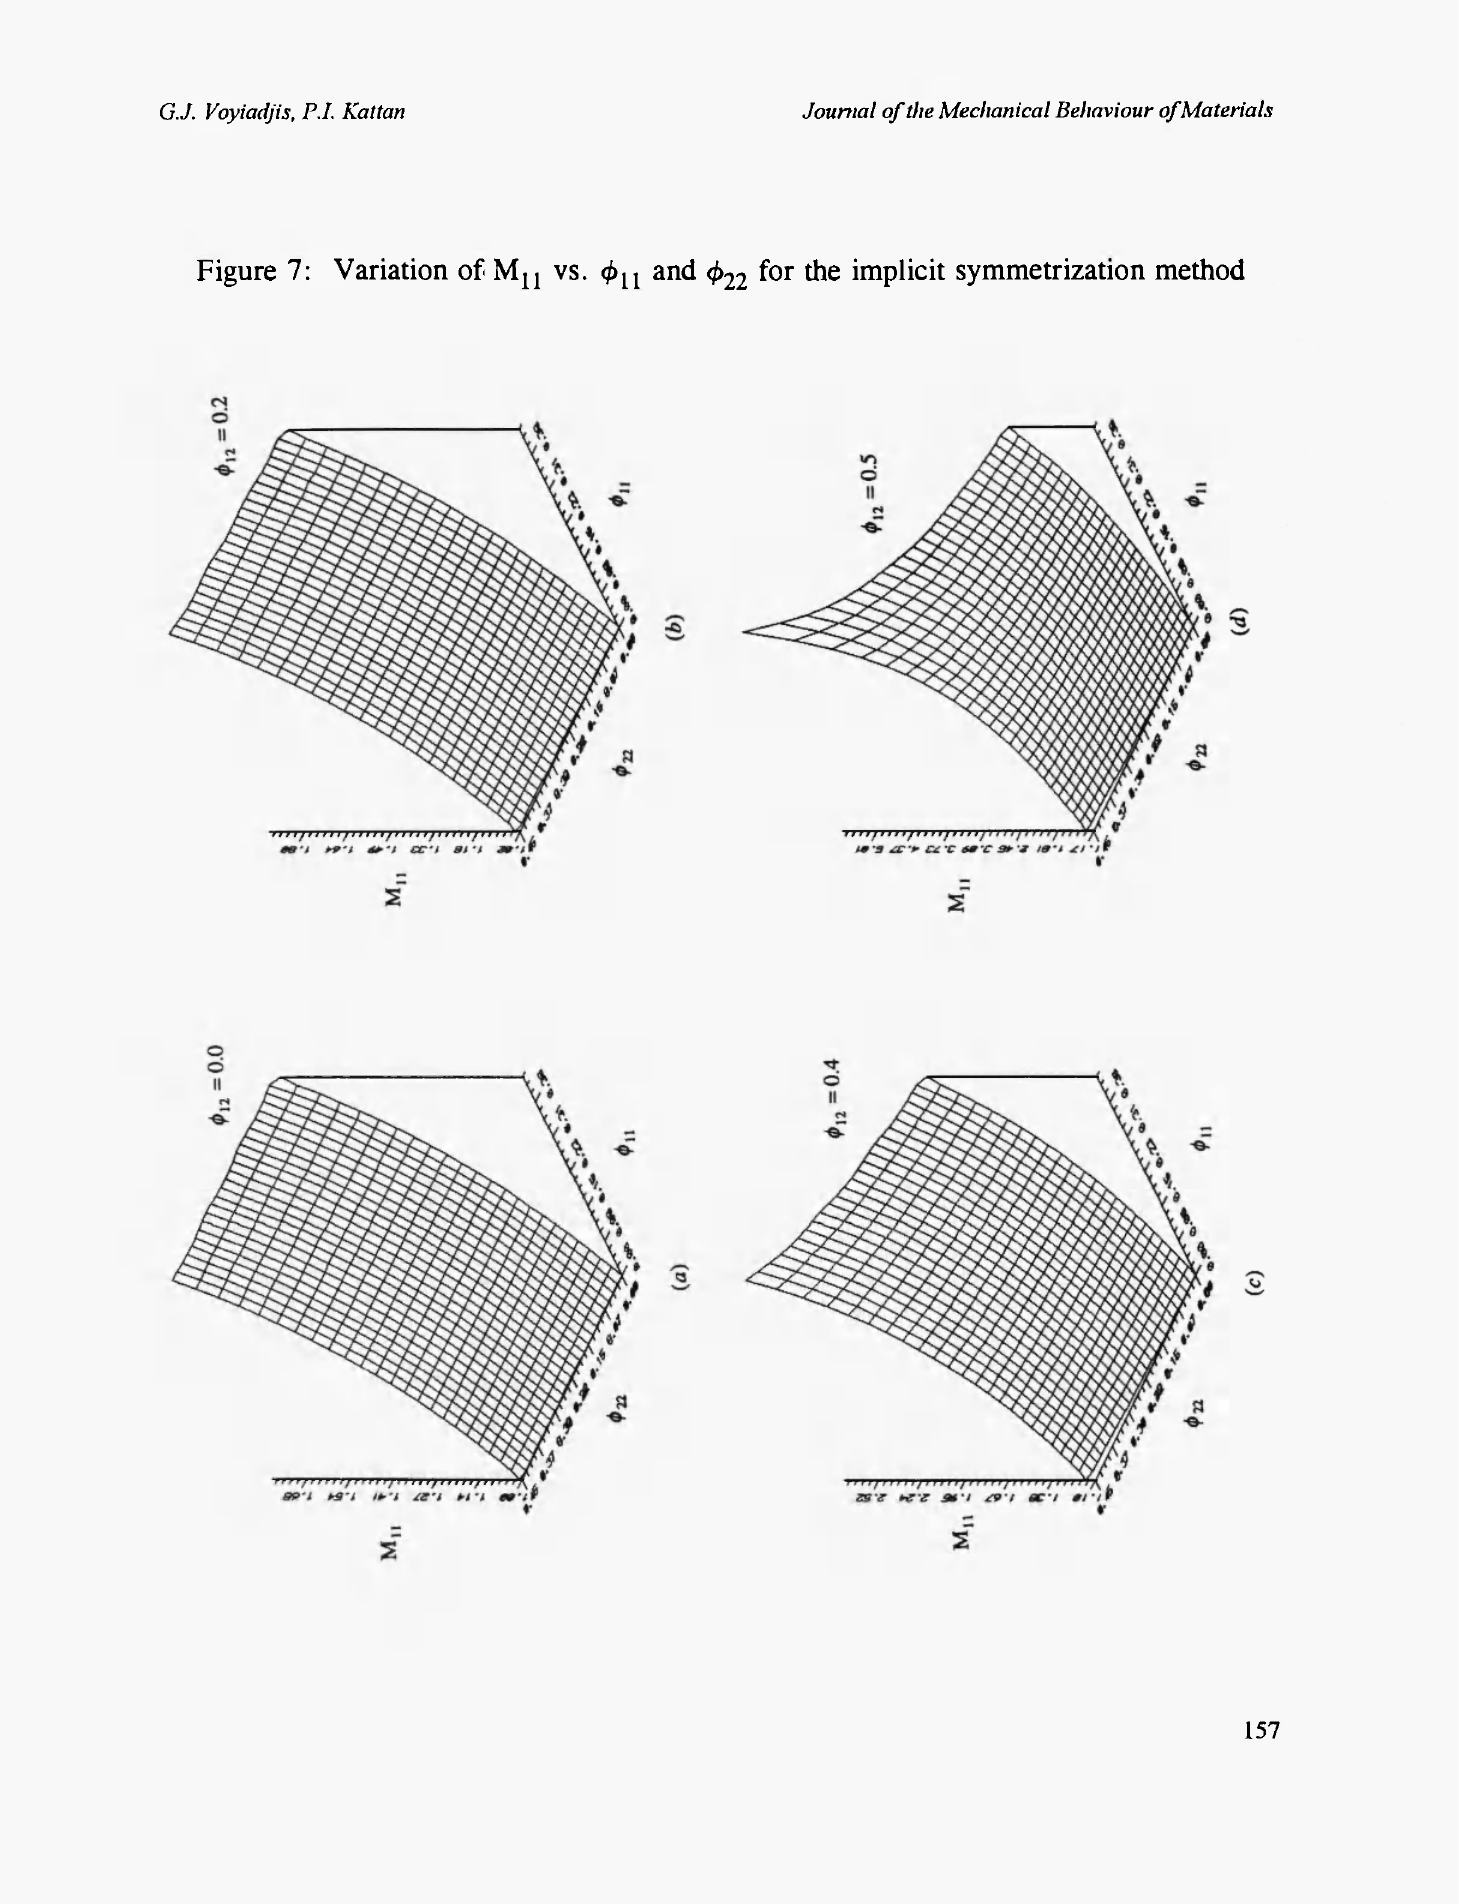
Figure 7: Variation of M